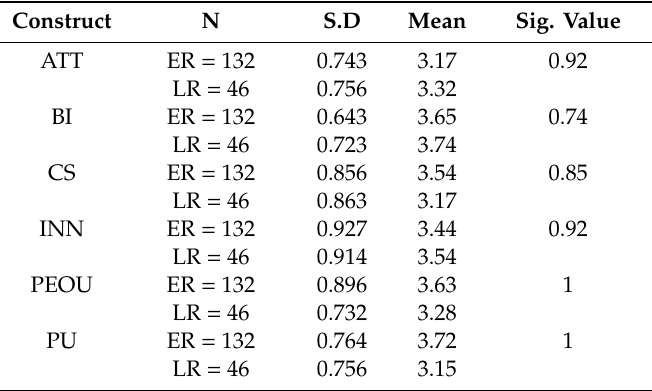
Table 4. Non-response bias.